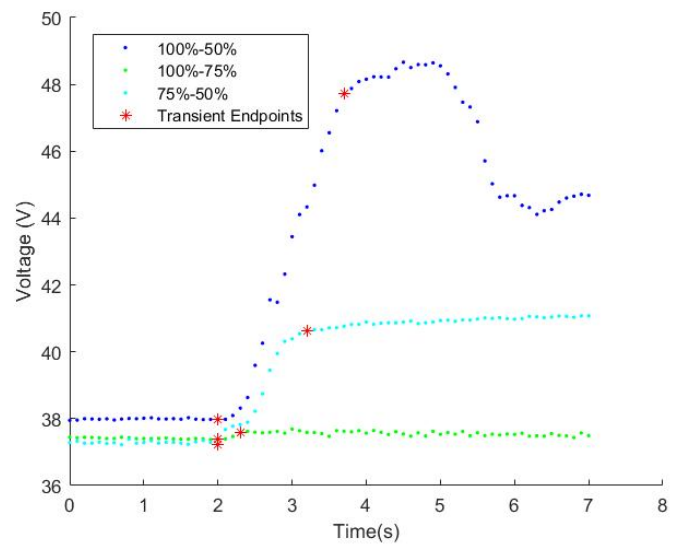
Figure 16. Voltages produced by the turboelectric system in ATC with negative throttle steps.